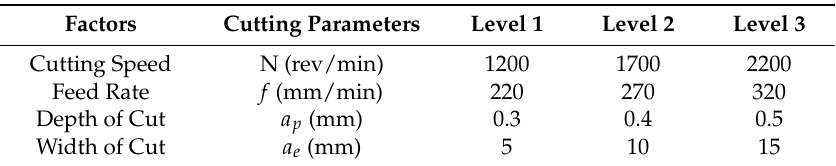
Table 1. Cutting parameters and their